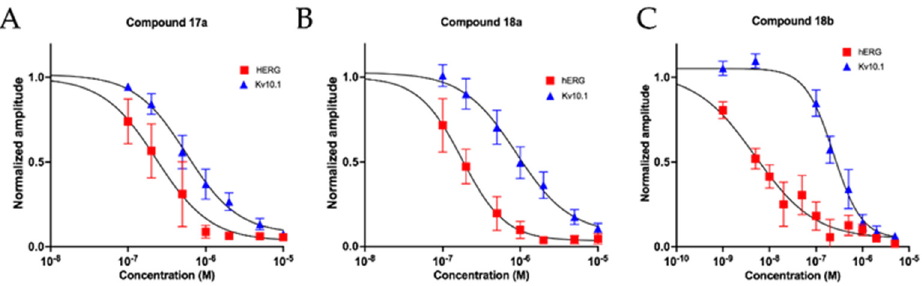
Figure 3. ( A ) Dose–response curves of compound 17a for K V 10.1 (blue) and hERG (red) inhibition. The IC 50 values from the fit were 568 nM (95% CI 427 to 783 nM N = 4–7) for K V 10.1 and 232 nM (CI: 186 to 296 nM N= 5–6) for hERG. ( B ) Dose–response curves of compound 18a for K V 10.1 (blue)